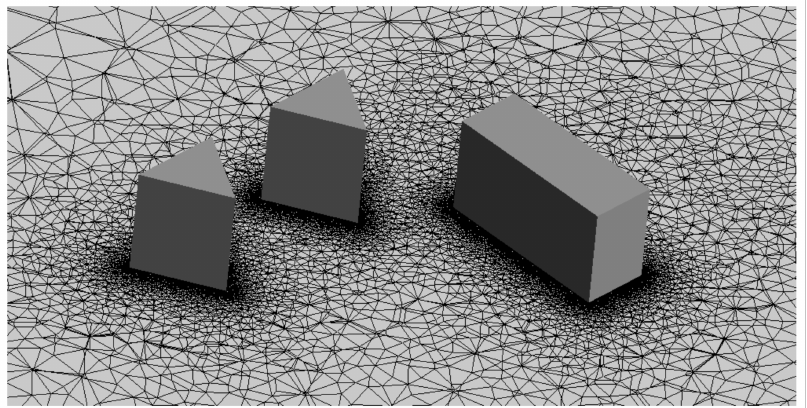
Figure 18. Generated mesh in close distance to the buildings, approximately in the center of its